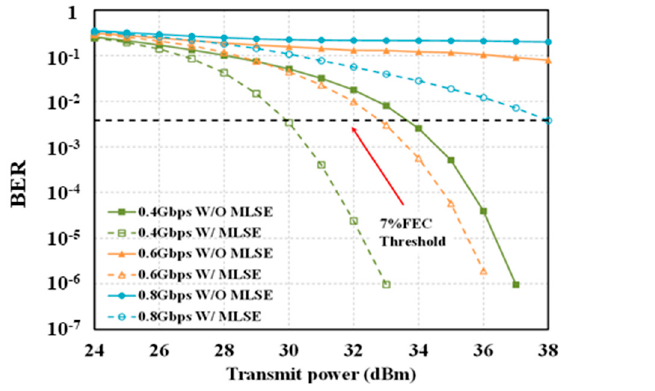
Figure 11. ( a ) 12 m transmission distance’s BER performance versus transmit power with OOK modulation in harbor water with 30° FOV. ( b ) 14 m transmission distance’s BER performance versus transmit power with OOK modulation in harbor water with 30° FOV.